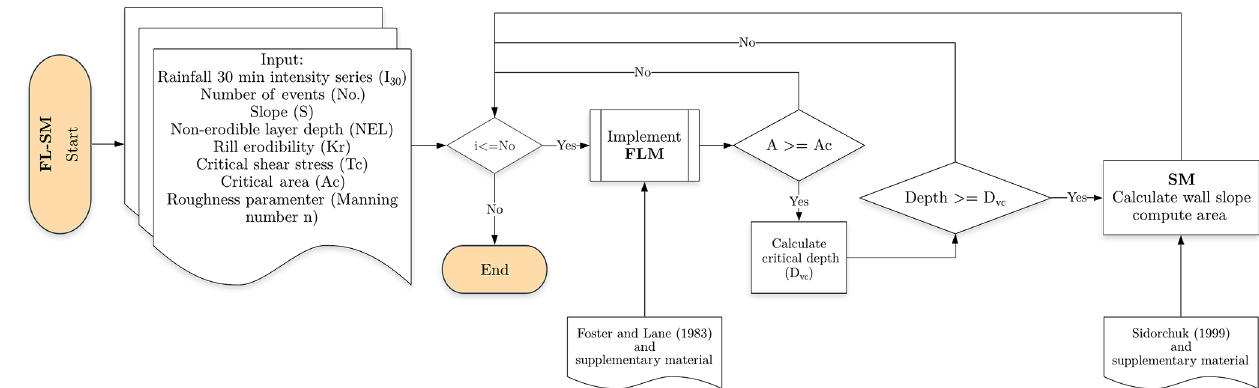
Figure 6. Flow chart of the coupled FL-SM model.